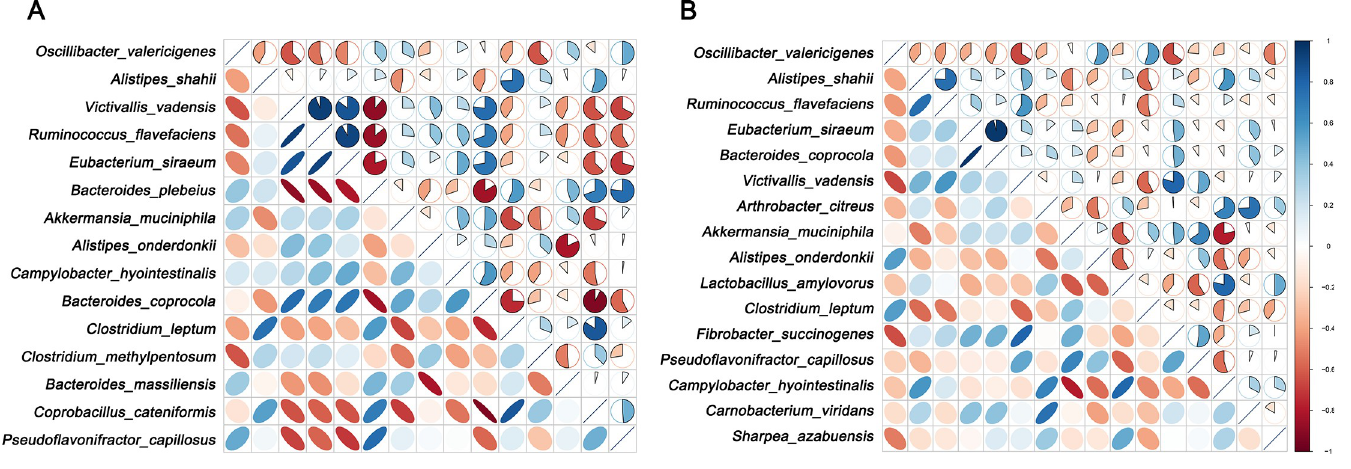
Fig 4. Correlation of core microbiota in BG (A) and WG